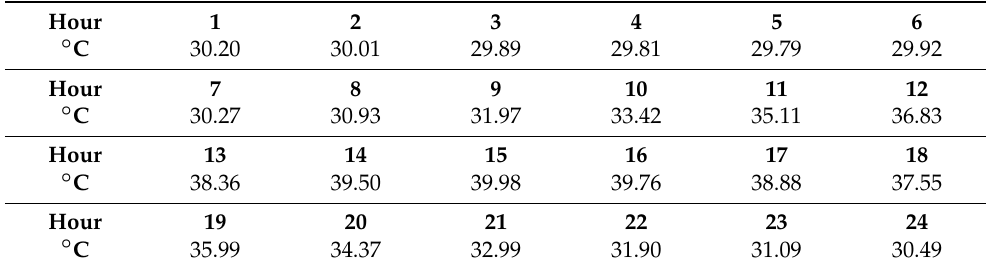
Table 13. Shanghai district design day.